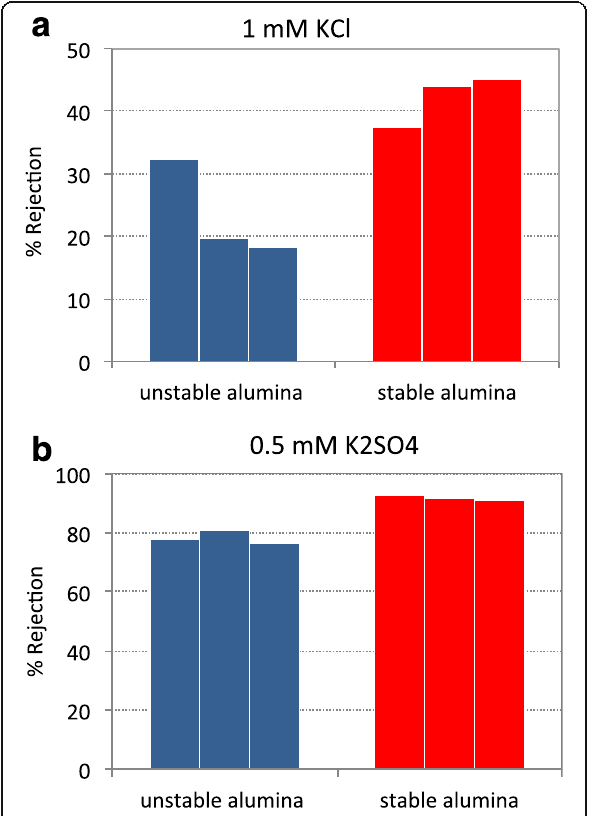
Fig. 6 Anion rejection coefficient for three membranes fabricated with VA-SWCNTs grown on stable (red) and unstable alumina (blue): a filtration of a 1 mM KCl solution; b filtration of a 0.5 mM K 2 SO 4 solution. % Rejection= [1 − ( c permeate / c feed )] × 100, where c permeate and c feed are the ion concentrations in permeate and feed,